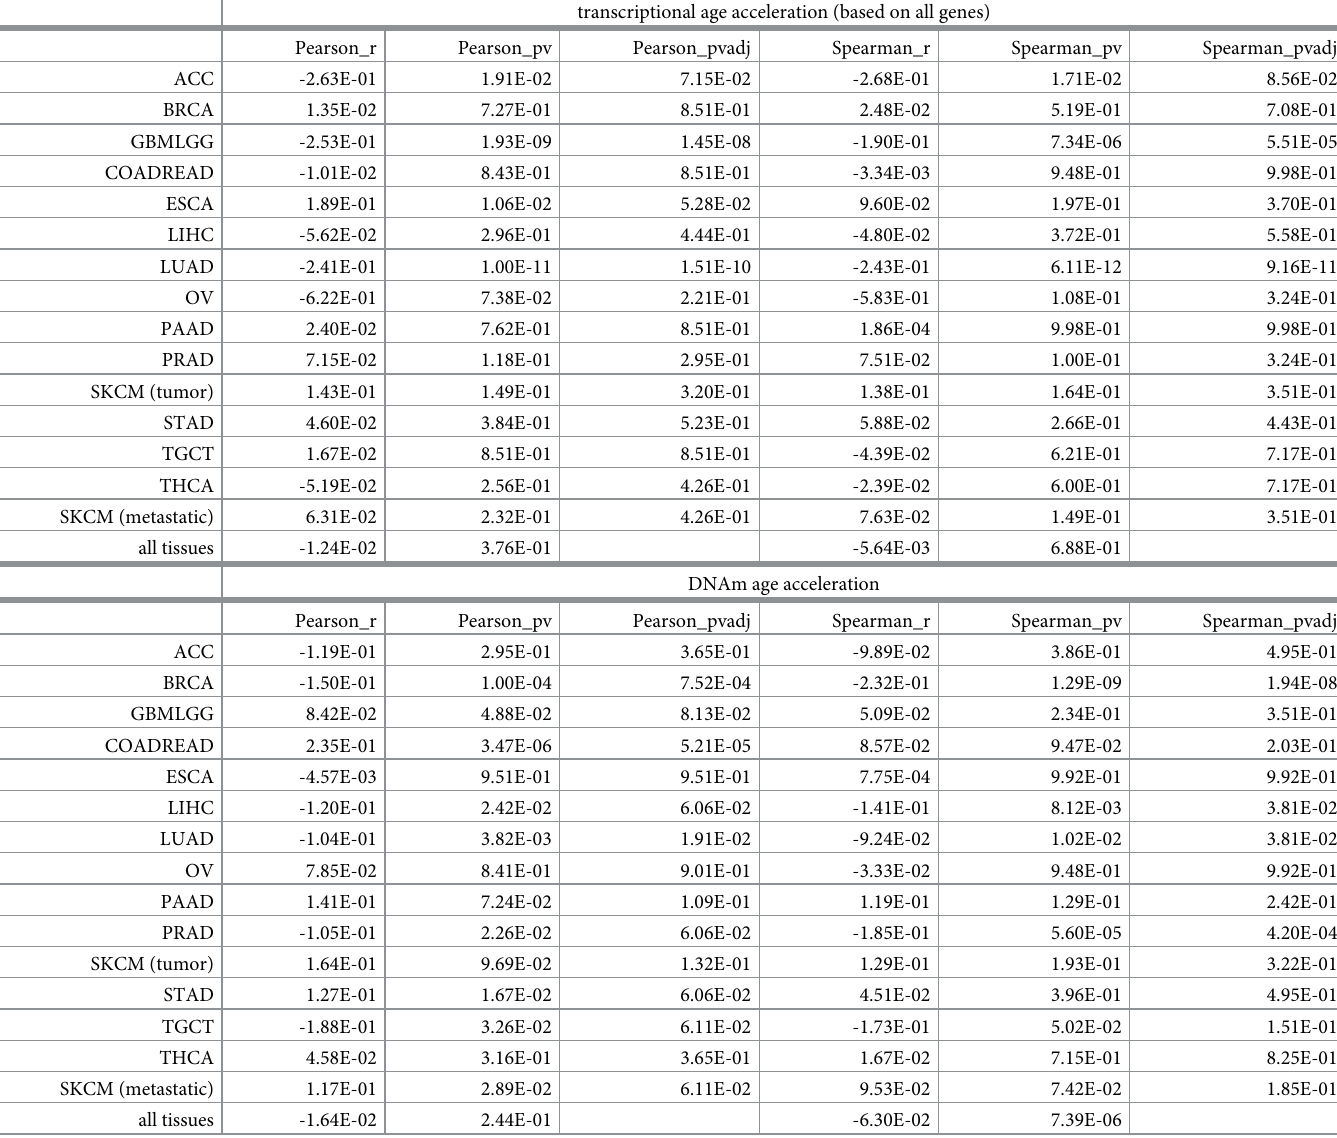
Table 2. Correlation between age acceleration residual and mutation burden.